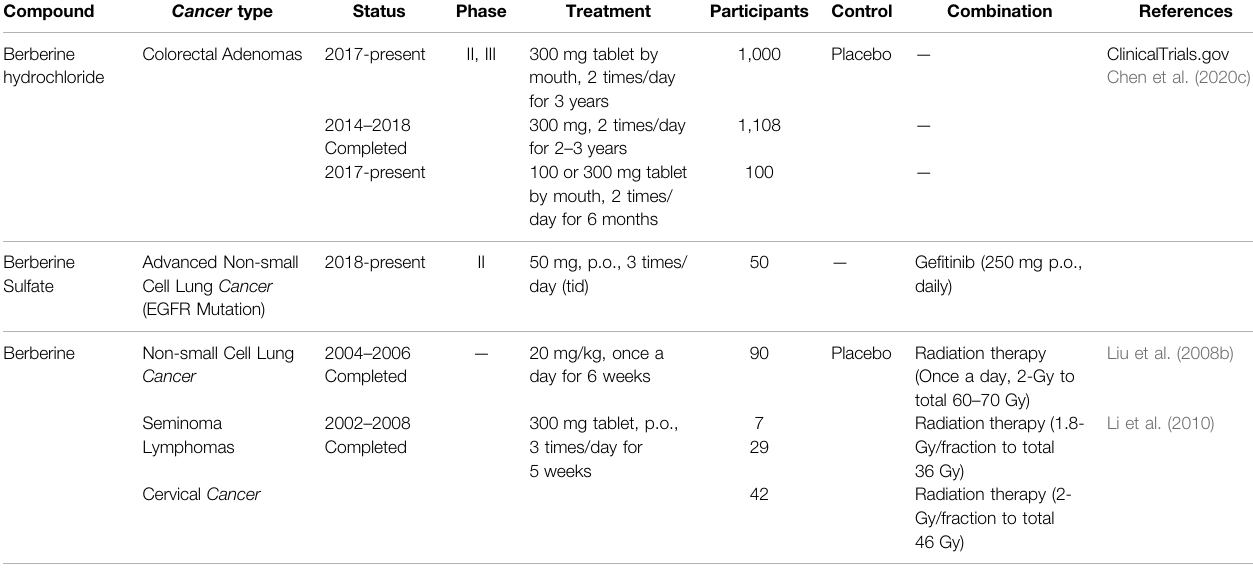
TABLE 2 | Clinical trials of berberine against cancers.